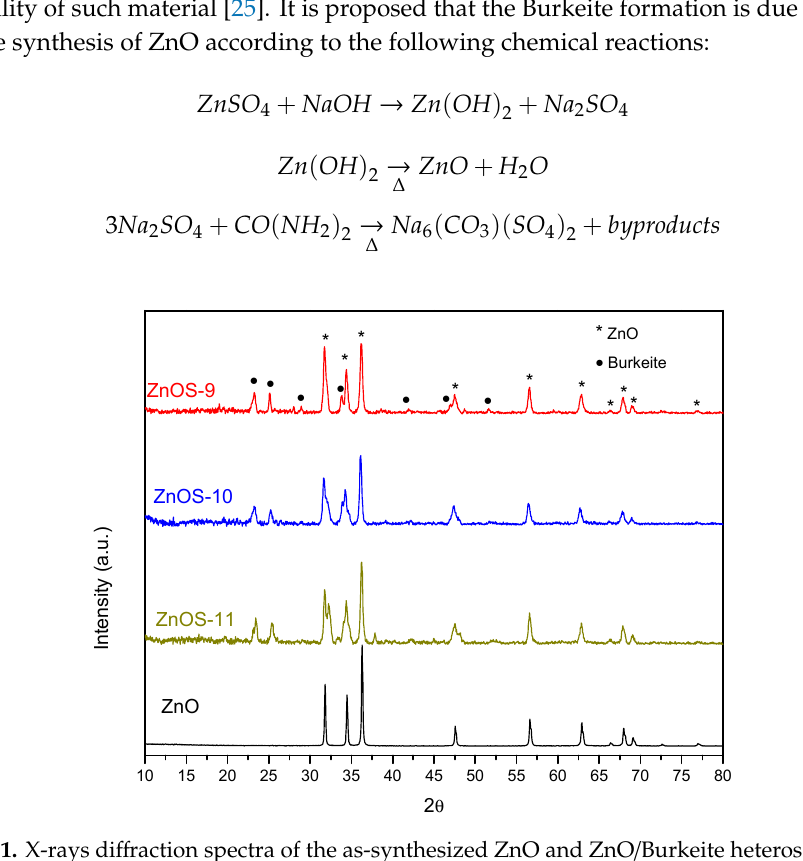
Figure 1. X-rays di ff raction spectra of the as-synthesized ZnO and ZnO / Burkeite Figure 1. X-rays diffraction spectra of the as-synthesized ZnO and ZnO/Burkeite heterostructures.